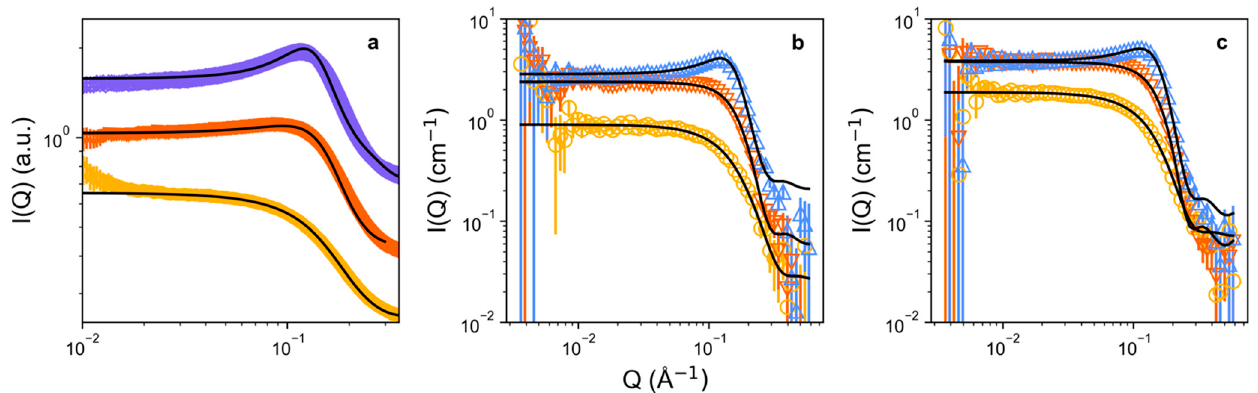
Figure 4. Measured and background-subtracted scattering data: ( a ) SAXS of C 12 TAB (5, 10, and 15 wt.%) in ethaline DES; ( b ) SANS of D-C 12 TAB (5, 10, and 20 wt.%) in H-ethaline DES; ( c ) SANS of H-C 12 TAB (5, 10, and 20 wt.%) in D-ethaline DES. Experimental surfactant concentrations are represented by yellow circles (5 wt.%), orange downwards triangles (10 wt.%), purple diamonds (15 wt.%), and blue upwards triangles (20 wt.%), whereas fits are shown as black lines. Data and fits are omitted where small-angle scattering could not be reliably fitted due to signal-to-noise ratio, i.e., for 2 wt.% samples of C 12 TAB.